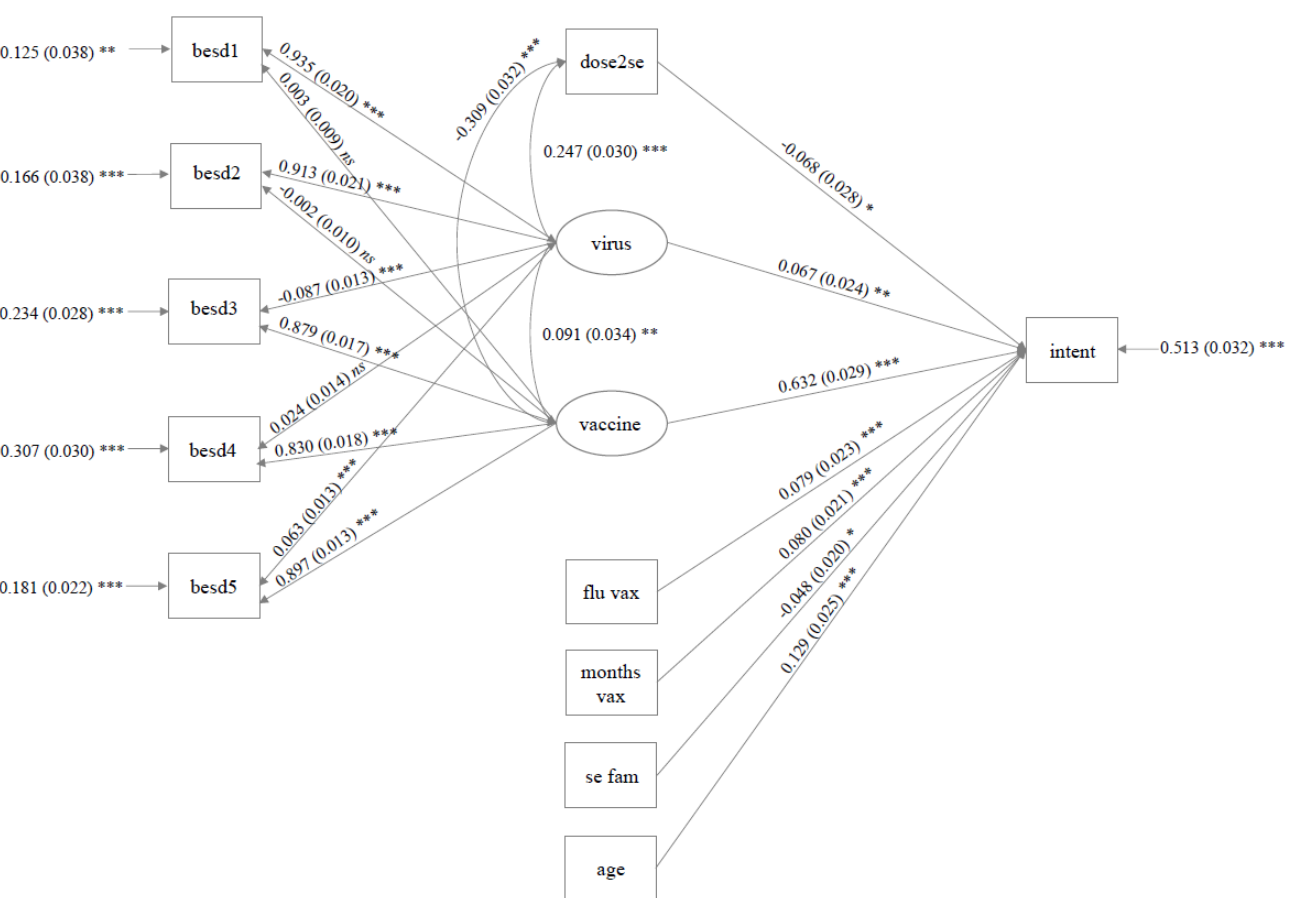
Figure 3. Variables in the final model concerning the Australian Sample. Note, statistics are reported as: standardised estimates (standard error) *** ( p < 0.001) ** ( p < 0.01); * ( p < 0.05). As in the UK model, covariance between latent variables and dose 2 side effects were included to improve fit. The latent variable ‘virus’ relates to psychological perceptions of the COVID -19 virus, and ‘vaccine’ to the COVID-19 vaccine. Other abbreviations are outlined in Table 1 above.